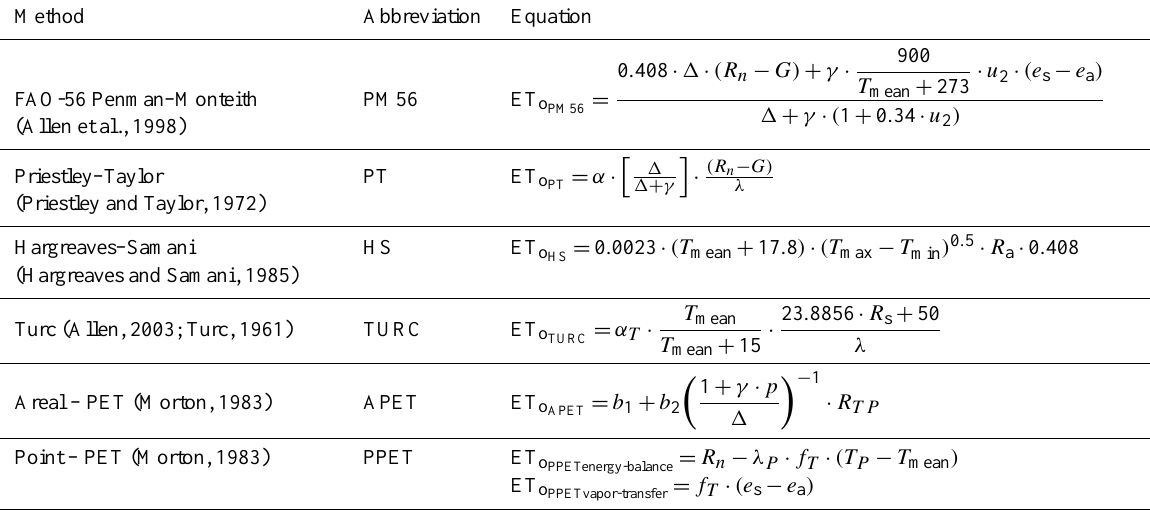
Table 2. The six equations applied for the calculation of reference